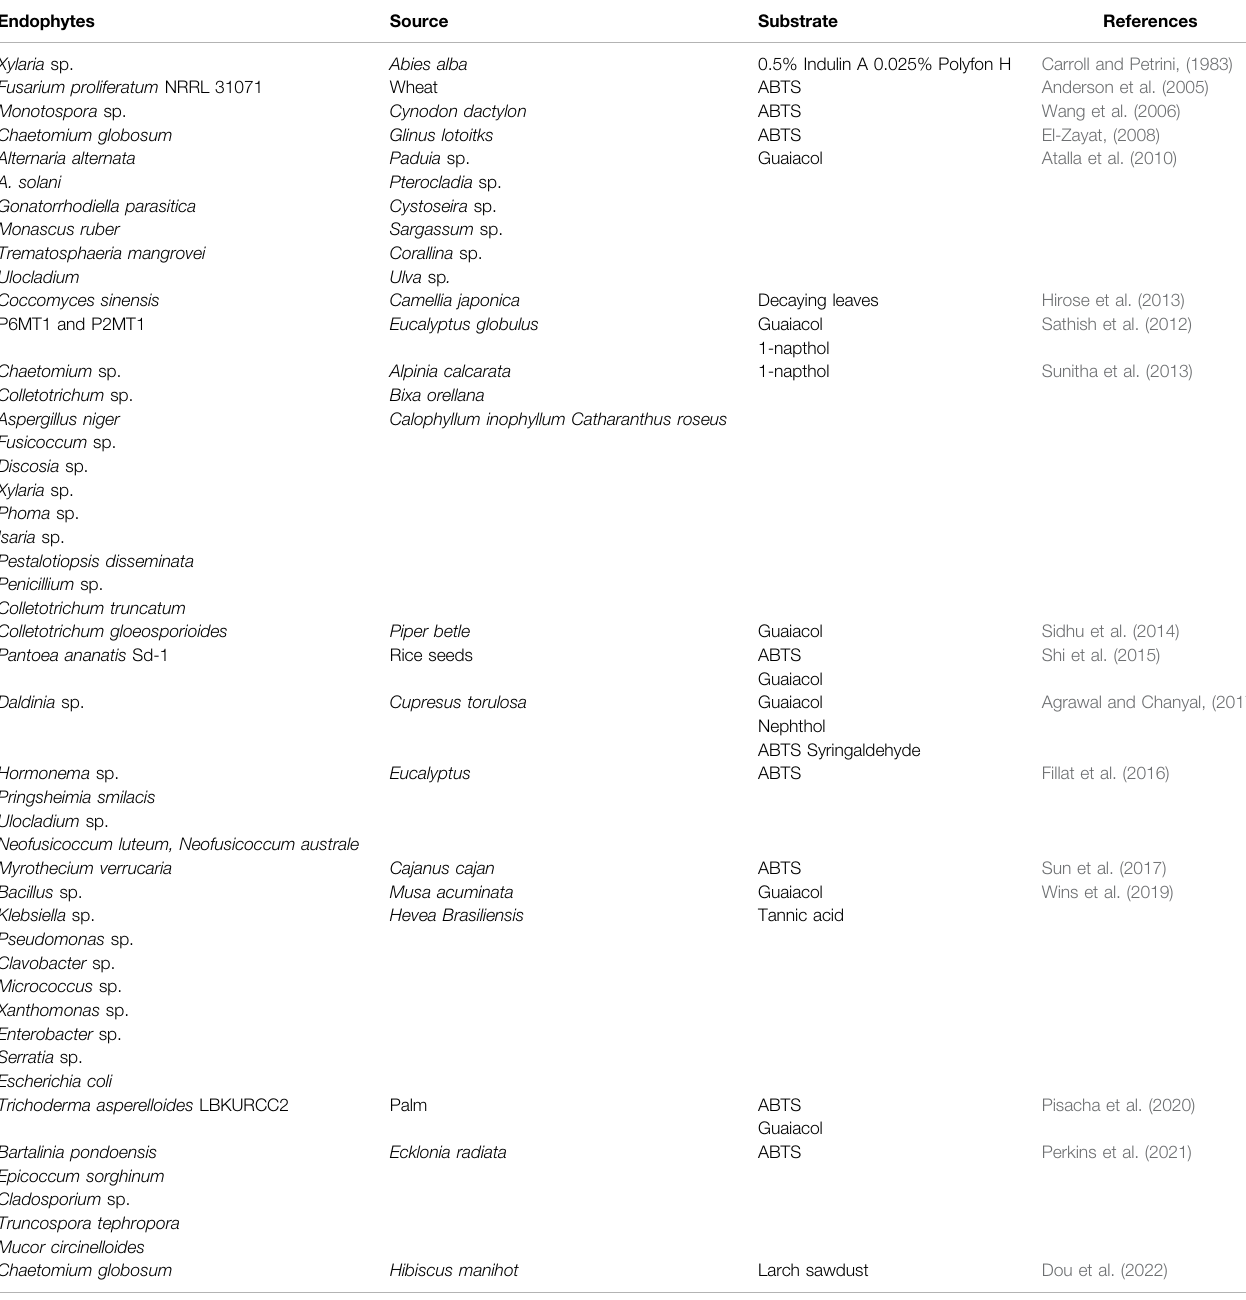
TABLE 2 | Lignin degrading ability shown by endophytes on various